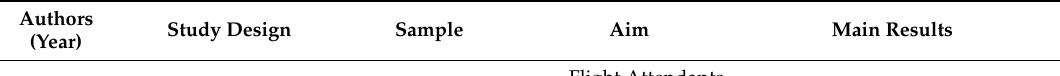
Table 3. Characteristics and main results of studies of flight